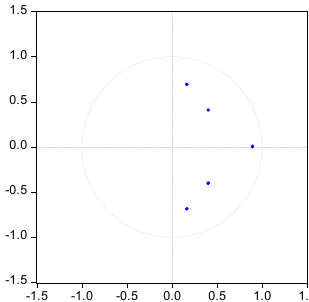
Figure 5. VAR roots of characteristic polynomial of mining and processing of non-ferrous metal ores. Note: blue dots indicate characteristic roots.